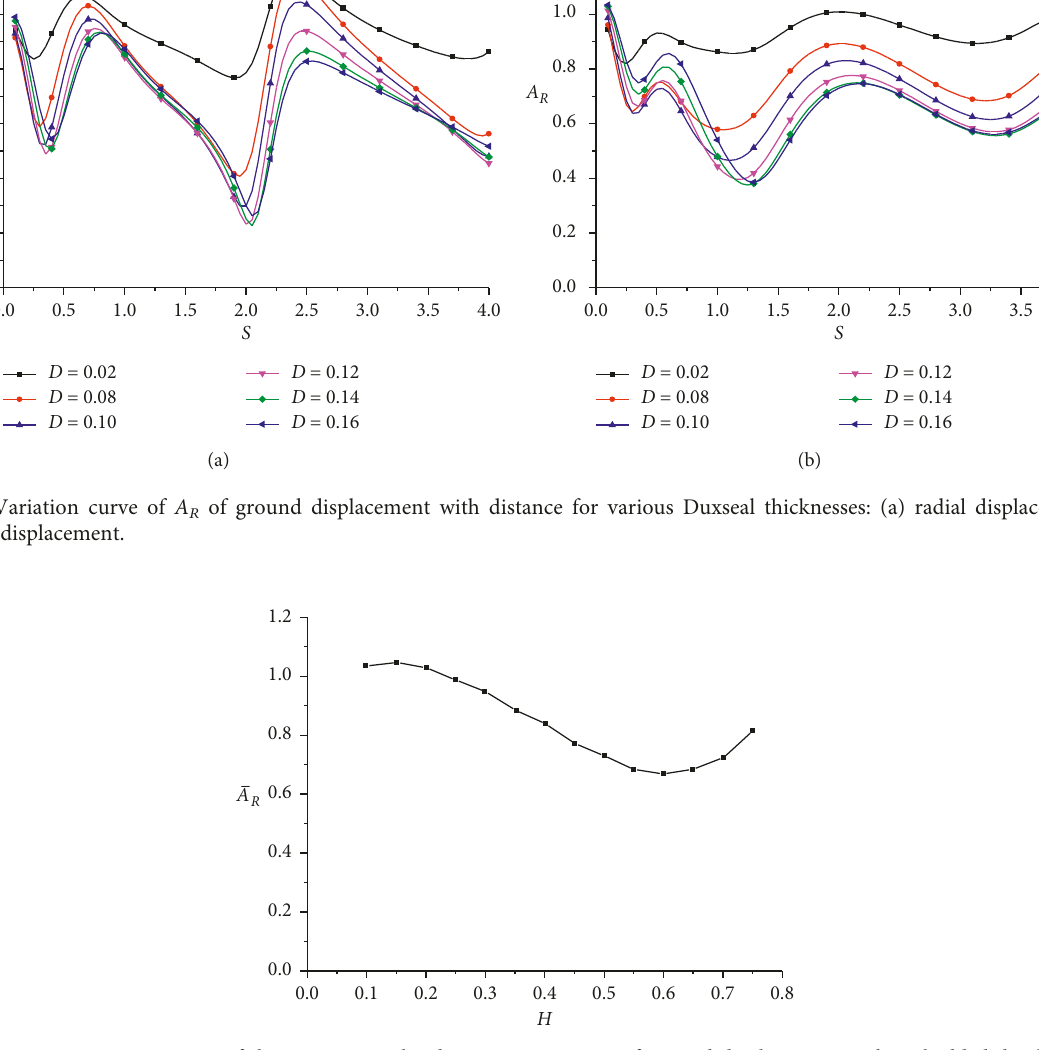
Figure 9: Variation curve of the average amplitude attenuation ratio of ground displacement with embedded